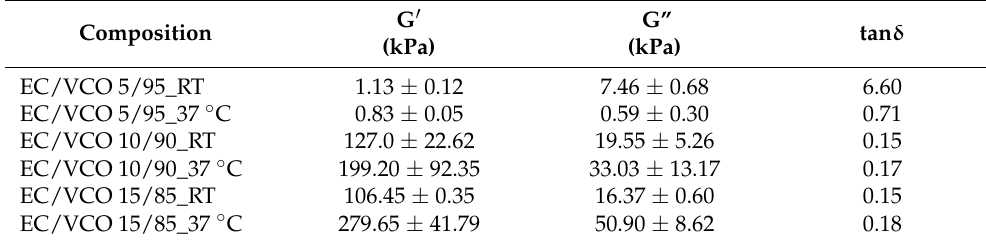
Table 2. Storage (G (cid:48) ), loss (G”), and loss factor ( δ ) moduli at 1 Hz frequency and 25 ◦ C.